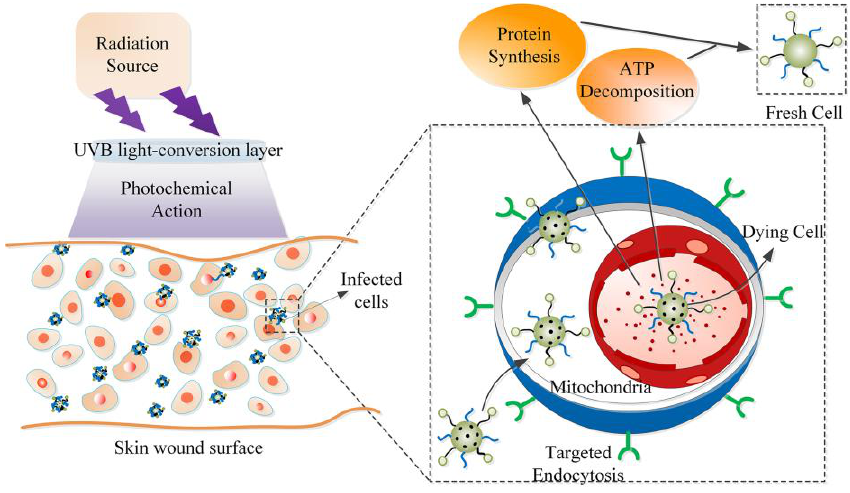
Figure 1. Scheme of light conversion layer for skin treatment using UVB emissions.